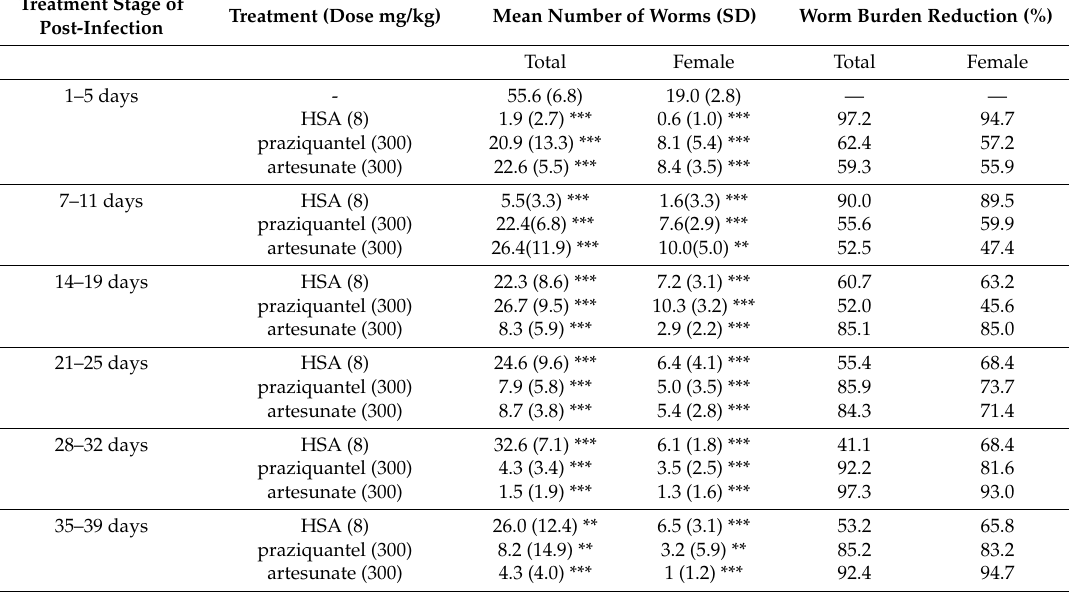
Figure 2. The antischistosomal effect of HSA against 1-day-old juvenile S. japonicum harbored in mice. Each point represents data from an individual treated or infected untreated mouse. Horizontal bars indicate mean values. The means ± SD (n = 8) for each experimental condition are as follows: Total (untreated: 55.6 ± 6.8; HSA: 1.9 ± 2.7; praziquantel: 20.9 ± 13.3; artesunate: 22.6 ± 5.5) and female (untreated: 19.0 ± 2.8; HSA: 0.6 ± 1.0; praziquantel: 8.1 ± 5.4; artesunate: 8.4 ± 3.5). Table 2. Stage-specificity of a single 8 mg · kg − 1 dose HSA, praziquantel or artesunate was administered to mice infected with S. japonicum .